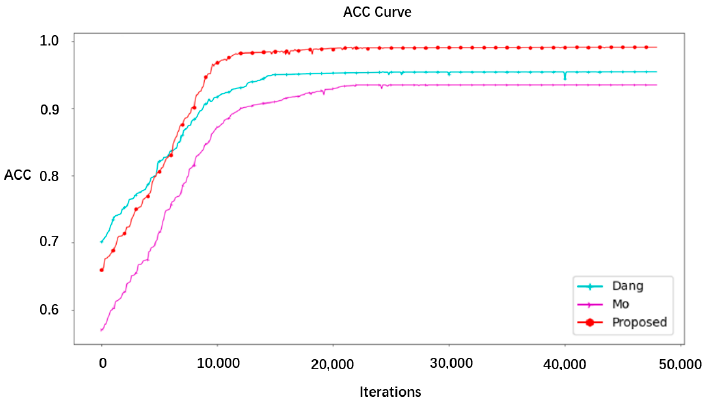
Figure 8. Accuracy curves of the different models. The confusion matrix performances of the three models on GS128 and C128 are shown in Figure 9.